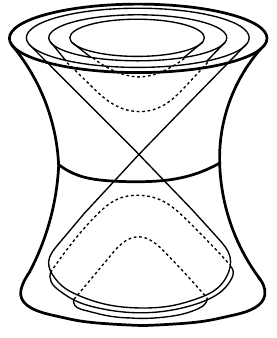
Figure 3 . Adjoint orbits of SO(2 ;